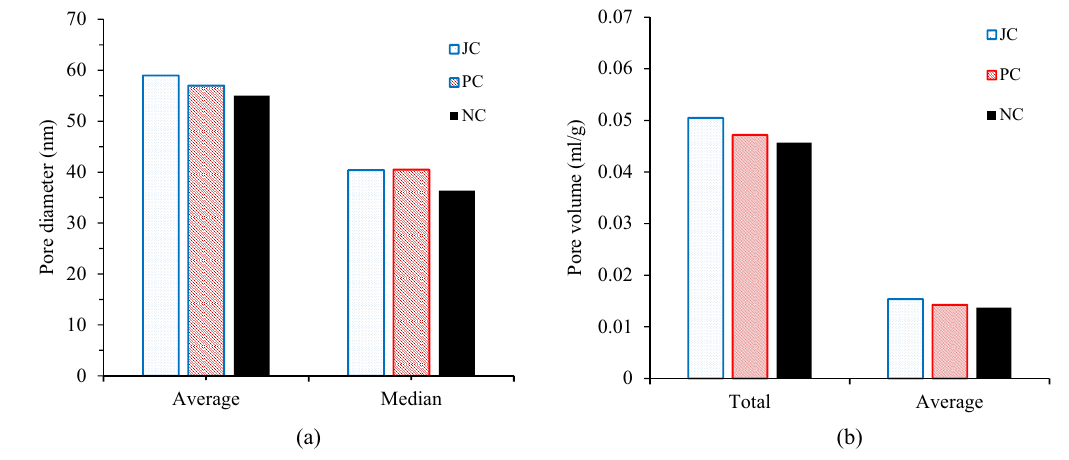
Figure 10: Comparison of ( a ) pore diameter and ( b ) pore volume of the